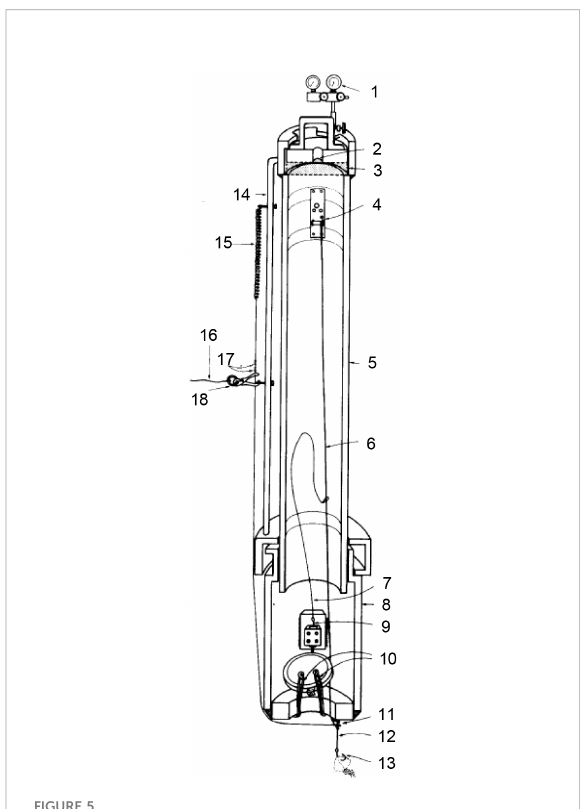
FIGURE 5 Cross section of hyperbaric fi sh trap (1:Pressure gauges; 2: Window to view fi sh; 3:Plexiglass; 4:Negator spring(pulls fi sh in- and closes door after tugging fi sh releases ballast); 5:Main AI tube; 6:Line between negator spring and fi sh hook; 7:Line to pin; 8:Large AI tube; 9:Pin; 10:Shock cords to close door; 11:Loops; 12:Taut wire inserted in small hole in end plate; 13:Baited hook; 14:Handling bracket; 15:Spring; 16:Line to baited strings and ballast weights; 17:crimps; 18:Fish-triggered release)(adapted from Phleger et al., 1979) Wilson and Smith (1985) established a hyperbaric trap-aquarium (Figure 6). The device contains an aluminum pressure vessel (inner diameter, 22.9cm, outer diameter, 26.7cm) with an adequate volume of